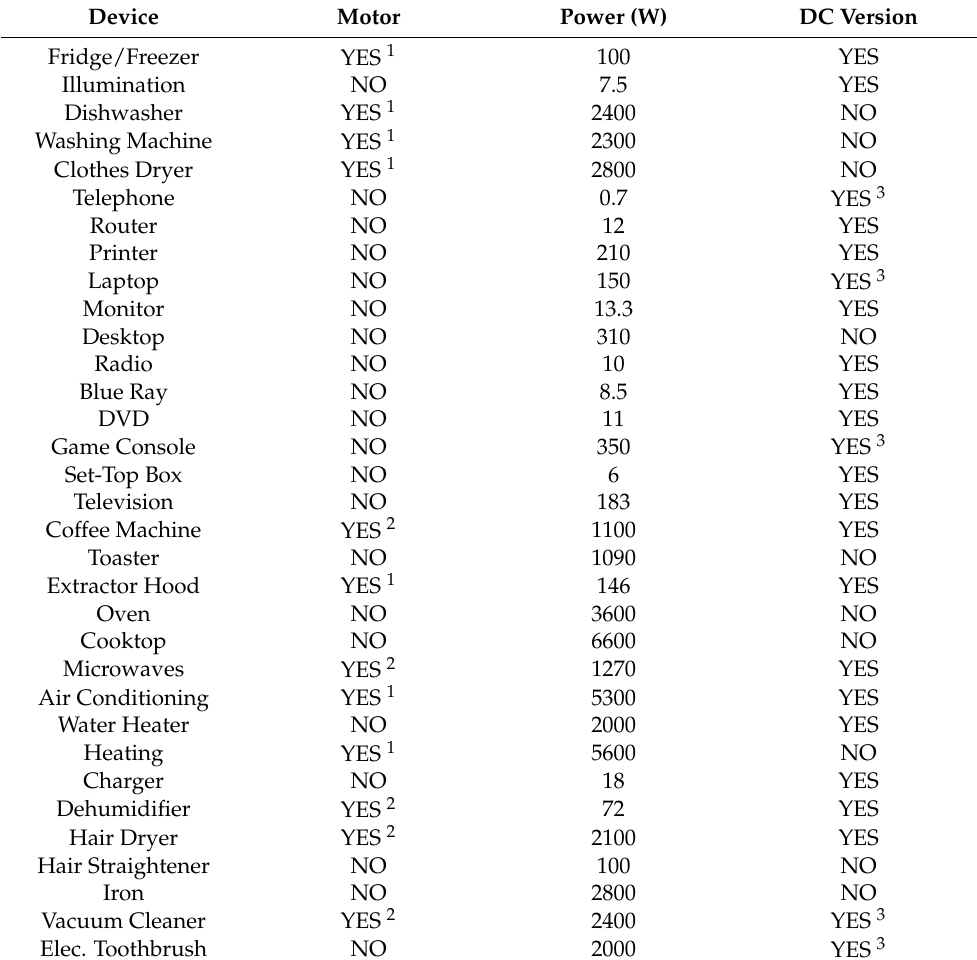
Table 1. Analysis of different household